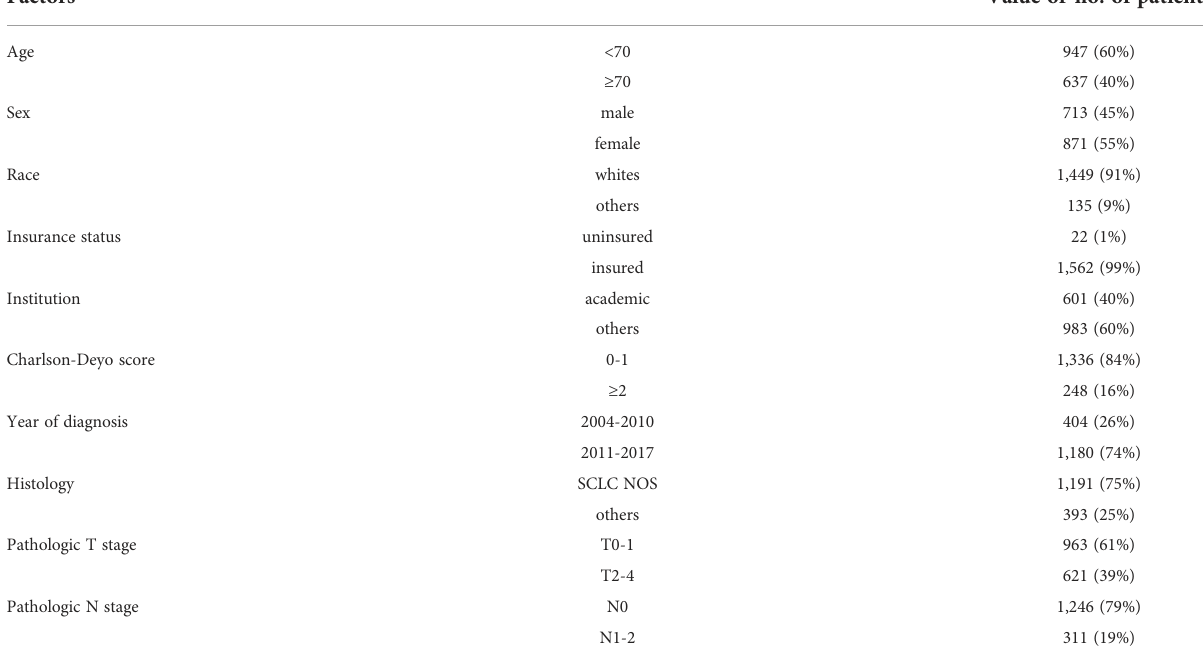
Factors Value or no. of patients